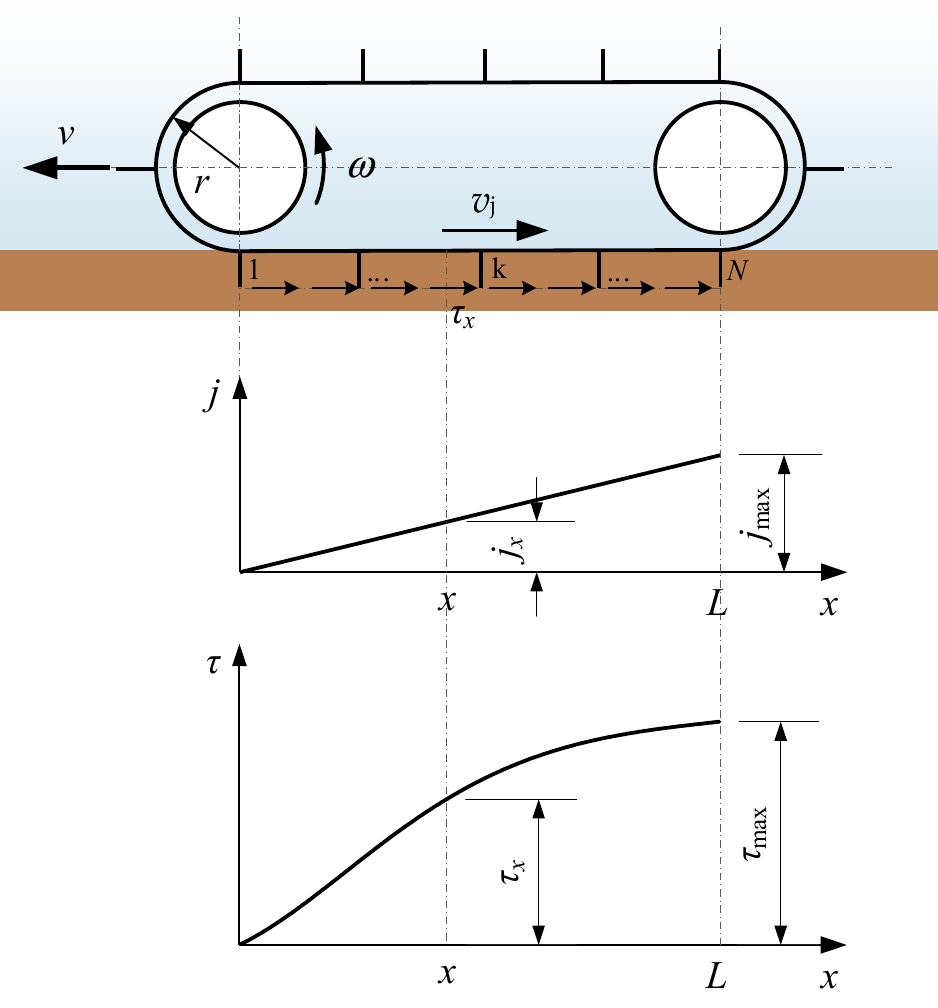
Figure 1. Classical traction model.